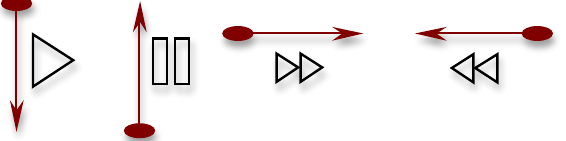
Figure 8: A video control system using gestures without visual repre- sentation D WELL C